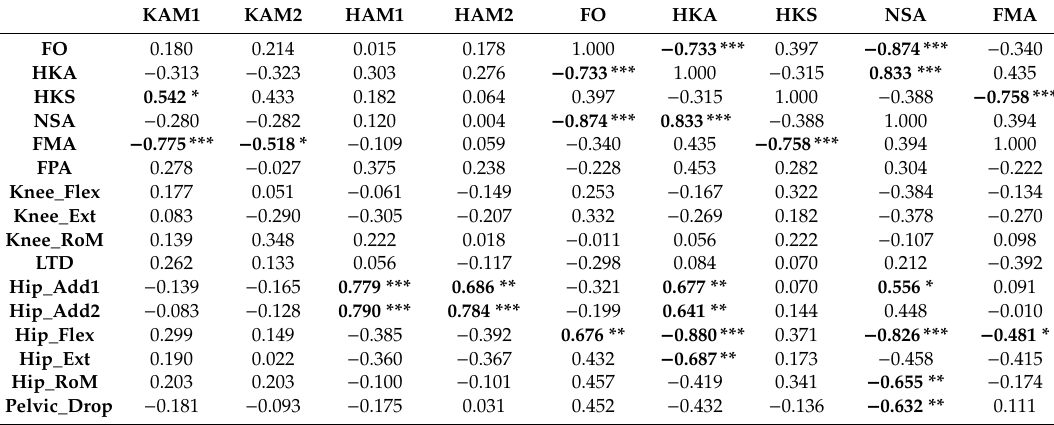
Table 5. Correlations between the joint adduction moments, joint kinematics, and the clinical leg parameters for the non-involved